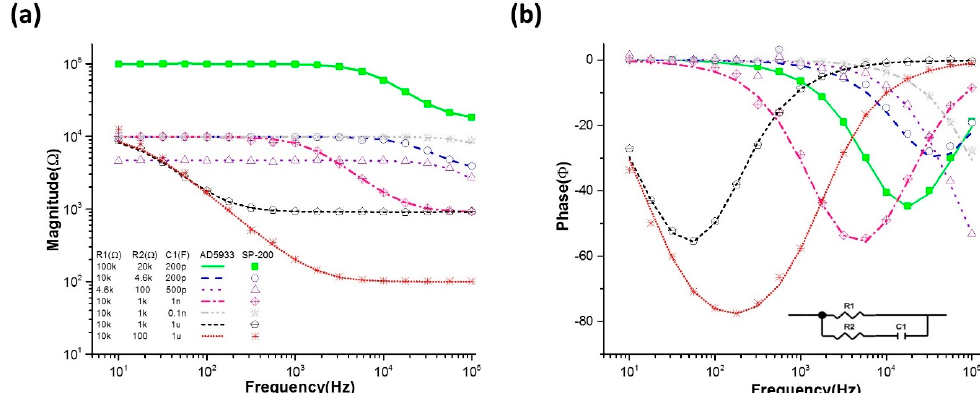
Figure 4. ( a ) Impedance magnitude and ( b ) phase of the resistor–resistor–capacitor (RRC) circuit Figure 4. Bode plot of the RRC circuit measured by the AD5933-based impedance measurement measured with respect to di ff erent C1, R1, or R2 by the AD5933 based impedance measurement system system compared with that of the profit-oriented product (SP-200). compared with data measured by the commercialized product